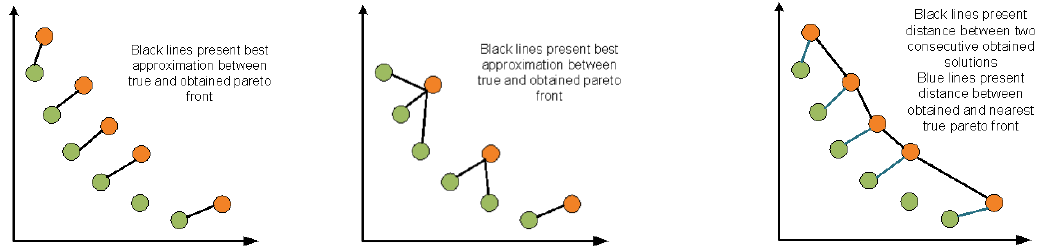
t PF indicate the nearest point on the true Pareto front from . . i p